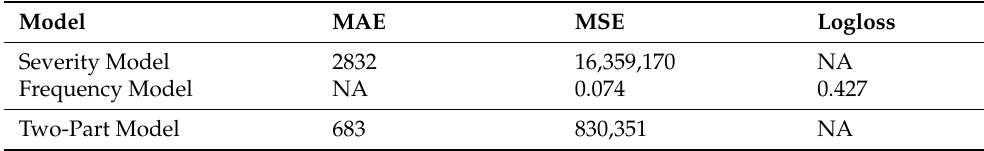
Table A3. Model metrics for all